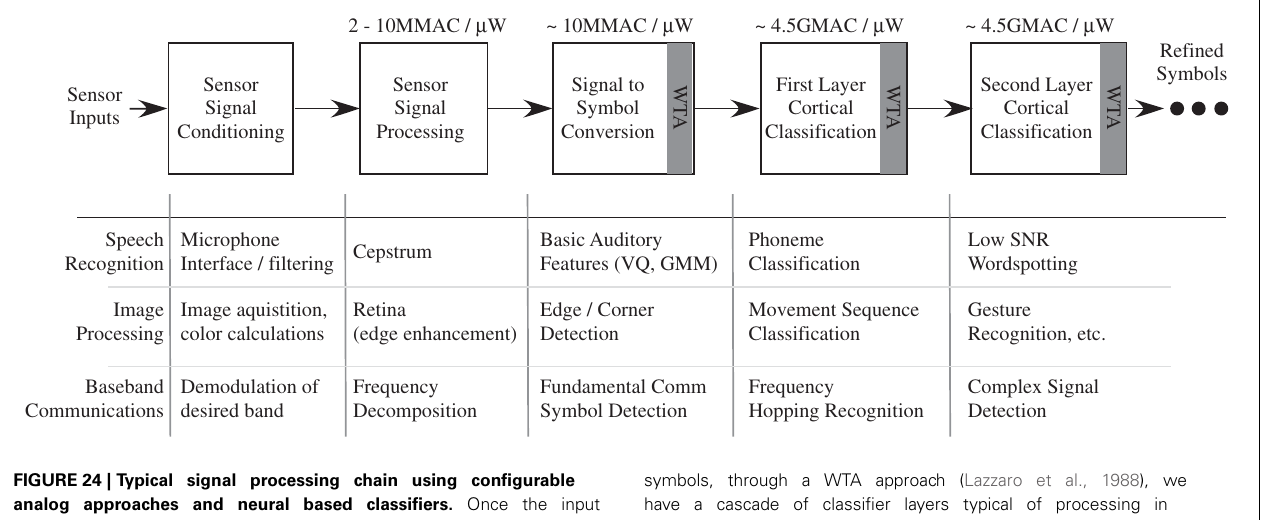
symbols, through a WTA approach (Lazzaro et al., 1988), we have a cascade of classifier layers typical of processing in